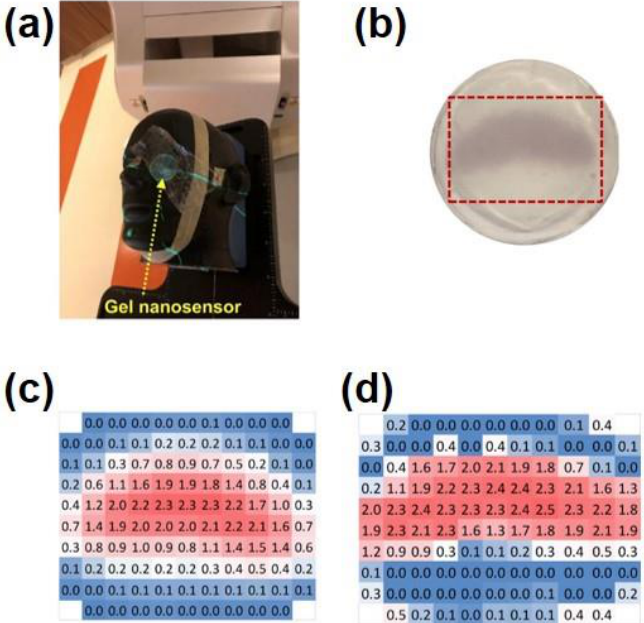
Figure 8. ( a ) A gel dosimeter mimics a conventional course of radiation therapy under the human left eye; ( b ) visual image of the dose pattern on the gel nanosensor formed after delivery of 2.3 Gy. (E) The core of the treated area with the expected crescent shape receives a radiation dose of 2.3 Gy (highlighted in red), and the areas receiving the lower dose are highlighted in different colors. ( c ) Expected topographical dose “heat map” profile of the radiation dose delivered to the gel placed in the phantom. ( d ) Radiation doses obtained from actual tests were broadly in line with expected estimates. Adapted from ref. [77] with permission from the American Chemical Society.